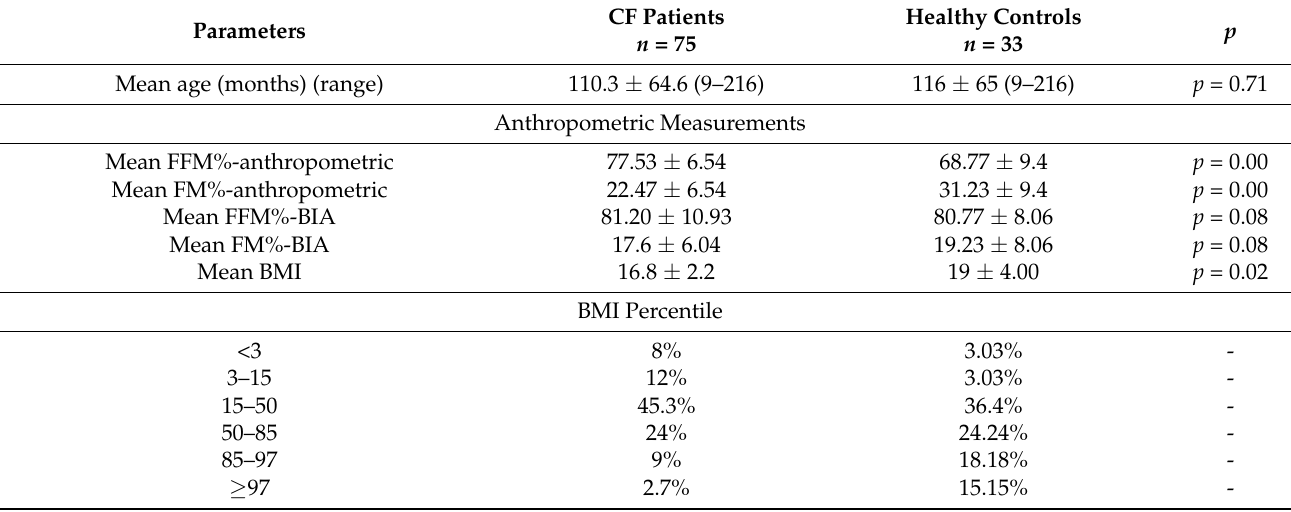
Table A1. Comparison of nutritional status between healthy children and CF